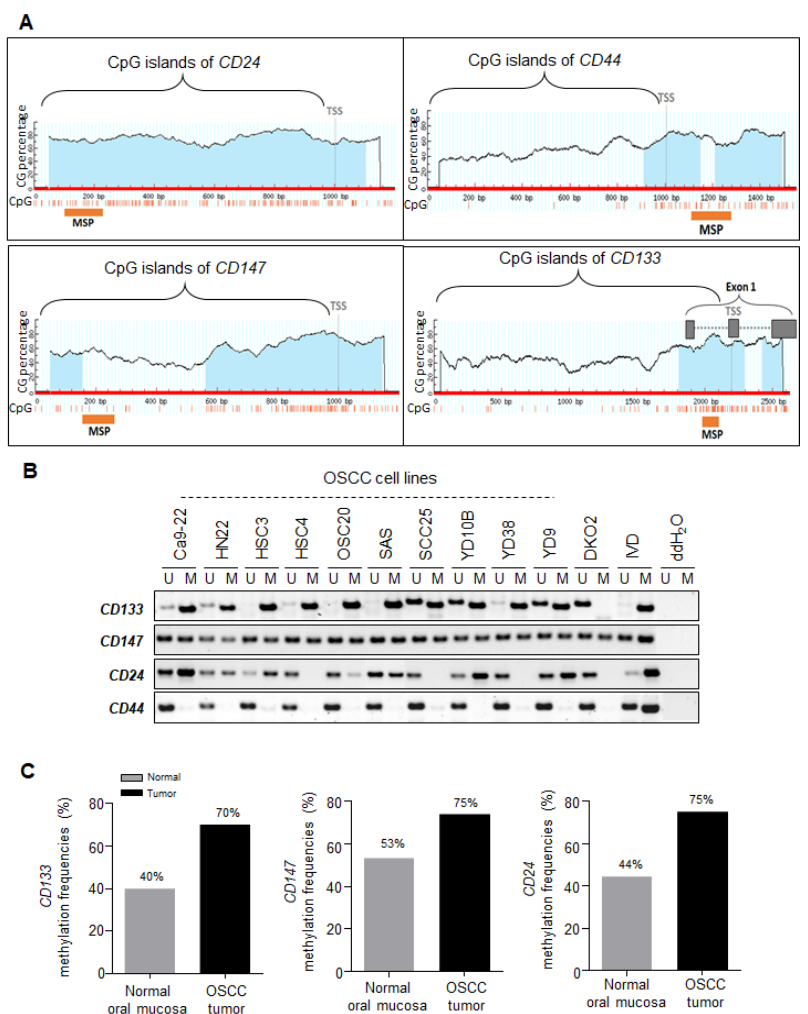
Figure 2. Promoter DNA methylation analysis of the CD24 , CD44 , CD133 , and CD147 genes in OSCC cell lines, primary OSCC tumor tissues, and normal oral mucosal tissues. ( A ) Schematic structure of the CpG islands at the promoter regions for CD24 , CD44 , CD133 , and CD147. ( A ) The primer locations for MSP were indicated as an orange bar for each gene. ( B ) MSP results in OSCC cell lines. Gel pictures describe the methylation analysis by MSP. DNA methyltransferase 1 and 3b knockout HCT116 cells (DKO) were included as positive controls. The PCR products recognized the unmethylated (U) and methylated (M) genes. DKO cells were used for the unmethylated control. IVD = in vitro methylated control; ddH 2 O = water control containing no DNA. ( C ) Methylation frequency of the CD24 , CD133 , and CD147 genes between the samples from patients with OSCC ( n = 102) and the normal oral mucosal tissue samples ( n = 45).